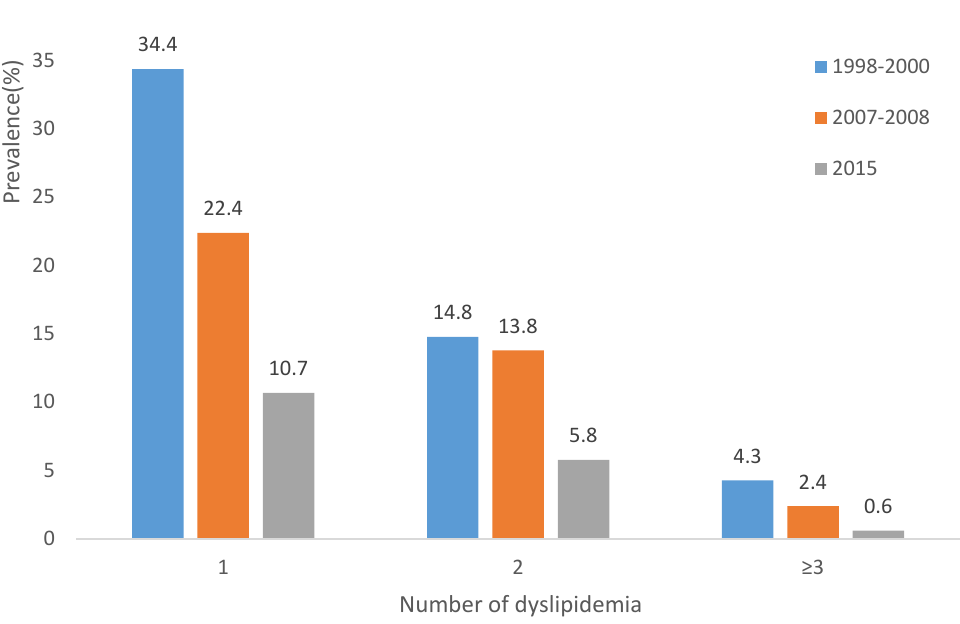
Figure 2. Trends in prevalence of the clustering of